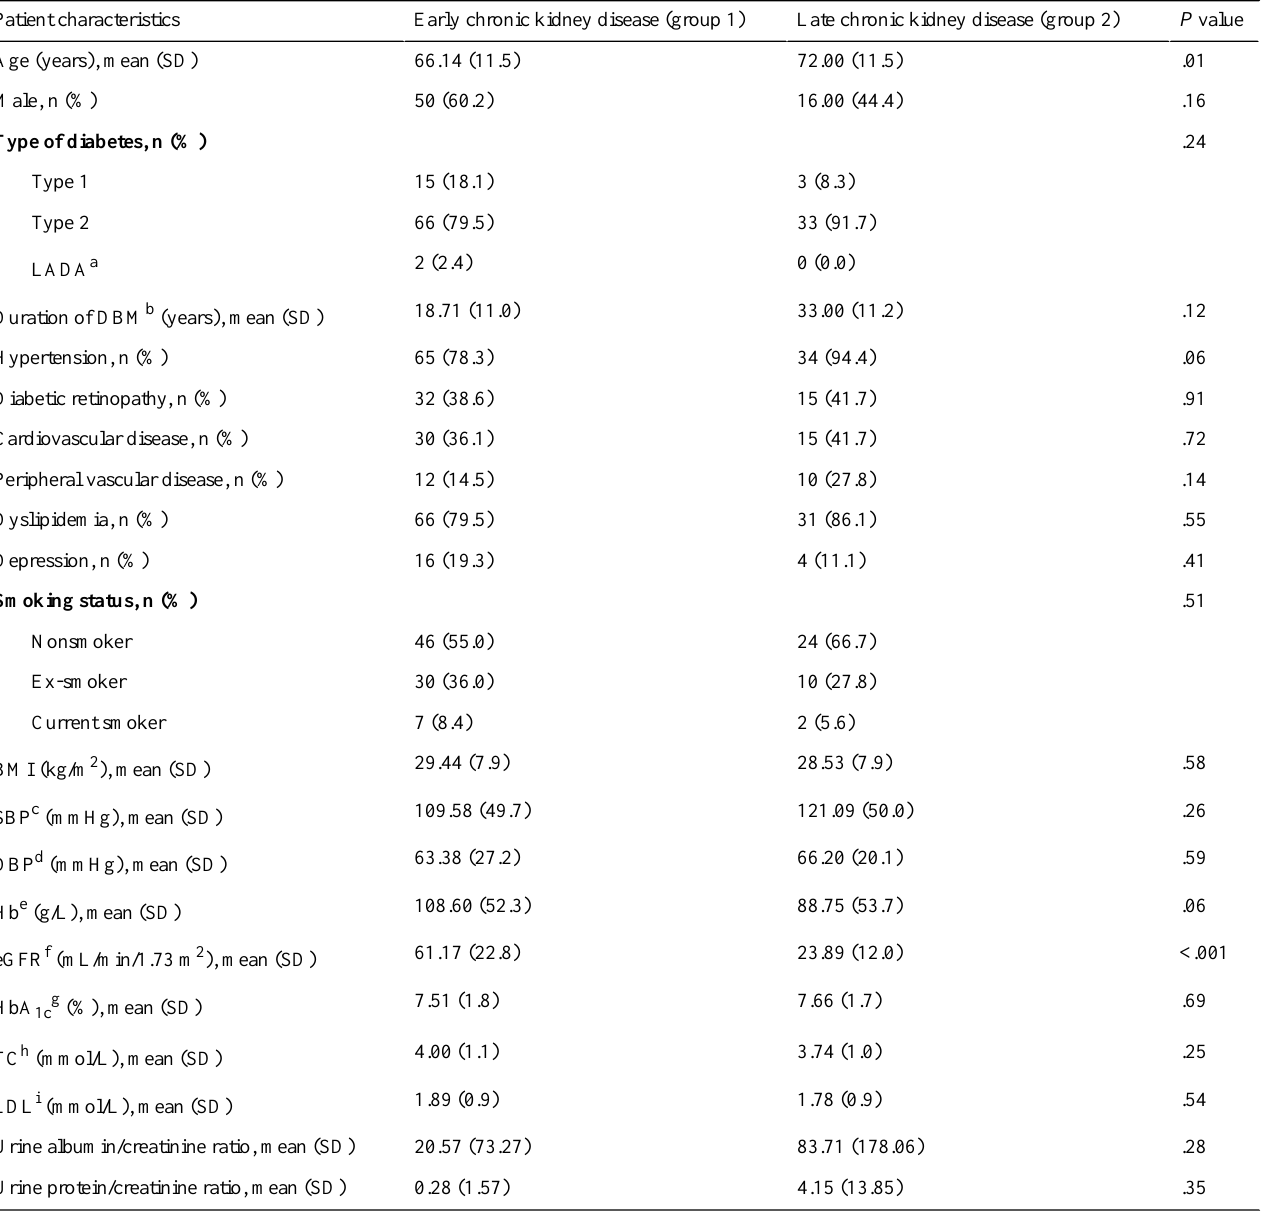
Table 3. Clinical and biochemical characteristics of the patient